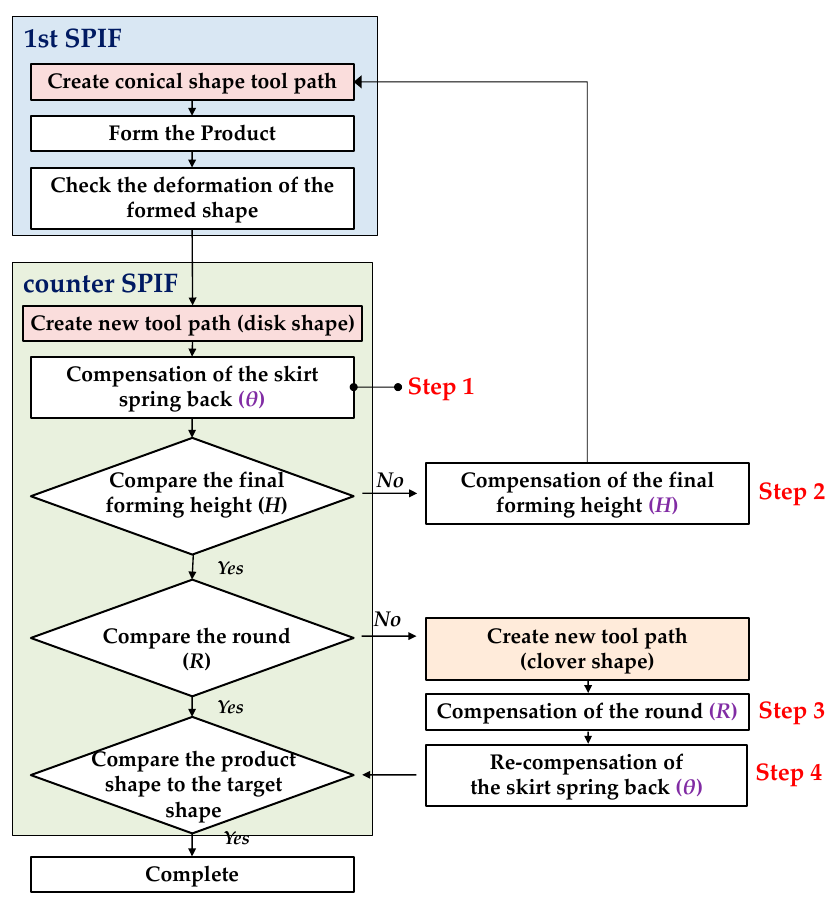
Figure 7. Flow chart to generate the tool path for the two-stage forming process.